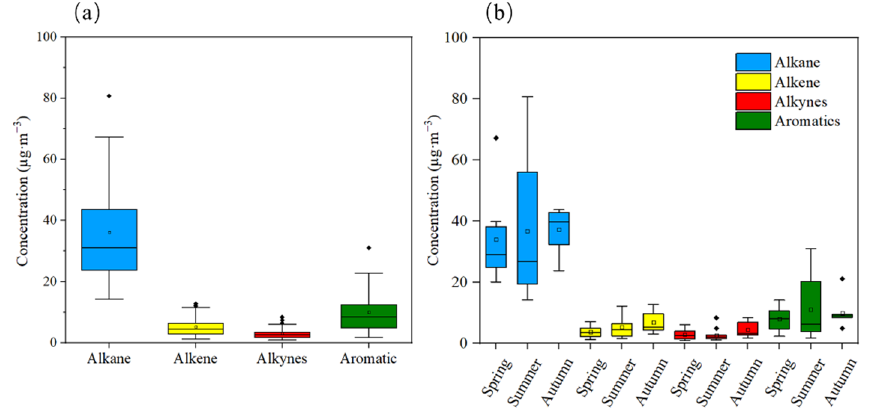
Figure 1. Concentration of various VOC groups in ( a ) total sampling time and ( b ) different seasons. Alkanes were the main components (66.8%) of VOCs in Changzhi, followed by aro- matic compounds (16.4%), alkenes (10.2%), and alkynes (6.6%). Higher alkane concentra- tions have also been observed in Beijing (58%) and Tianjin (63%) [40,41]. The proportion of different components of atmospheric VOCs in Changzhi presented clear seasonal changes, with higher levels of alkanes in the spring (70.3%) than in the summer (66.3%) and au- tumn (63.8%). The high proportion of alkanes in the spring was consistent with results obtained for other Chinese cities [12,42]. The contribution of aromatic compounds was higher in the summer (19.5%), followed by autumn (16.9%) and spring (15.6%). The high concentration of aromatics in the summer was also similar to results obtained for Shanghai and Tianjin [8,43]. The intensity of emissions from solvent evaporation and the chemical industry, which are the main sources of aromatics, increased in the summer because of the higher temperatures.